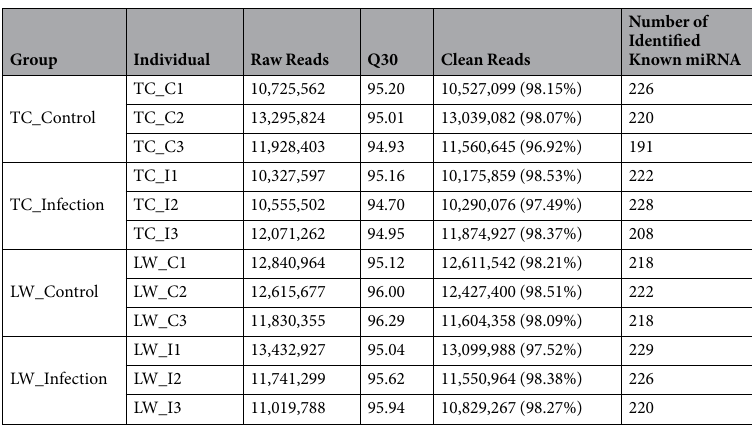
Table 1. Summary of small RNA